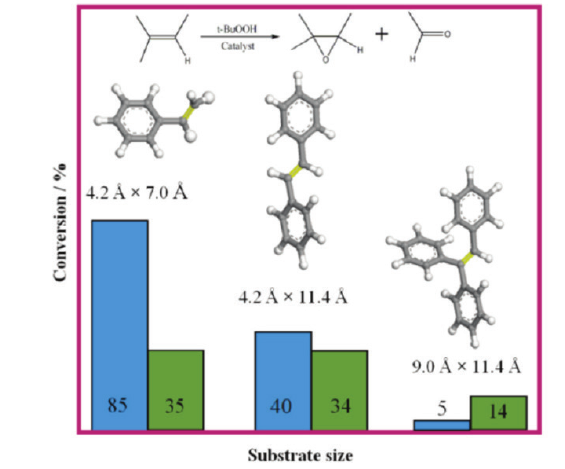
Figure 11 : Epoxidation of alkenes by porph@MOF-4 (blue) and Fe(III) TMPyP (green) showing good size-selective activity by porph@MOF- 4 [112]. Reprinted with permission from Ref. [112]. Copyright © 2012, American Chemical